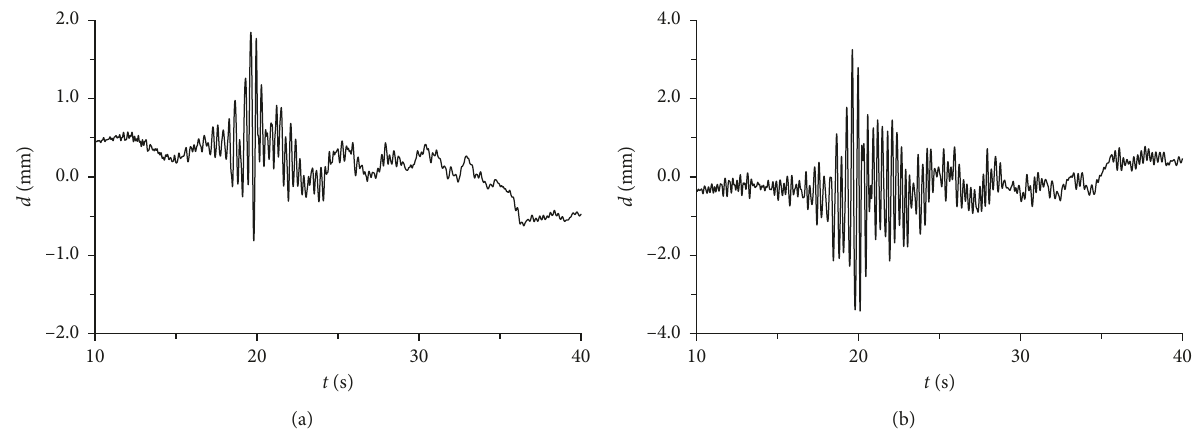
Figure 22: Relative displacement (a) between the first floor and the basement and (b) between the top and the first floor in the longitudinal